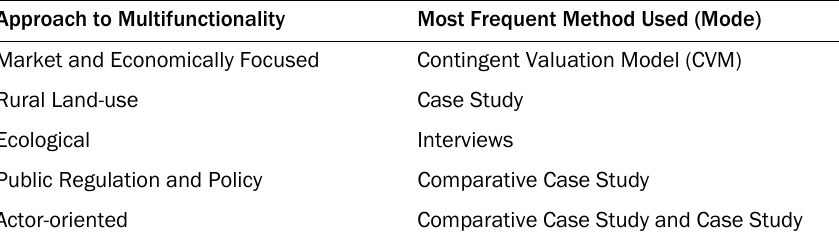
Table 2. Most Frequently Used Method by the Approach to Multifunctionality Approach to